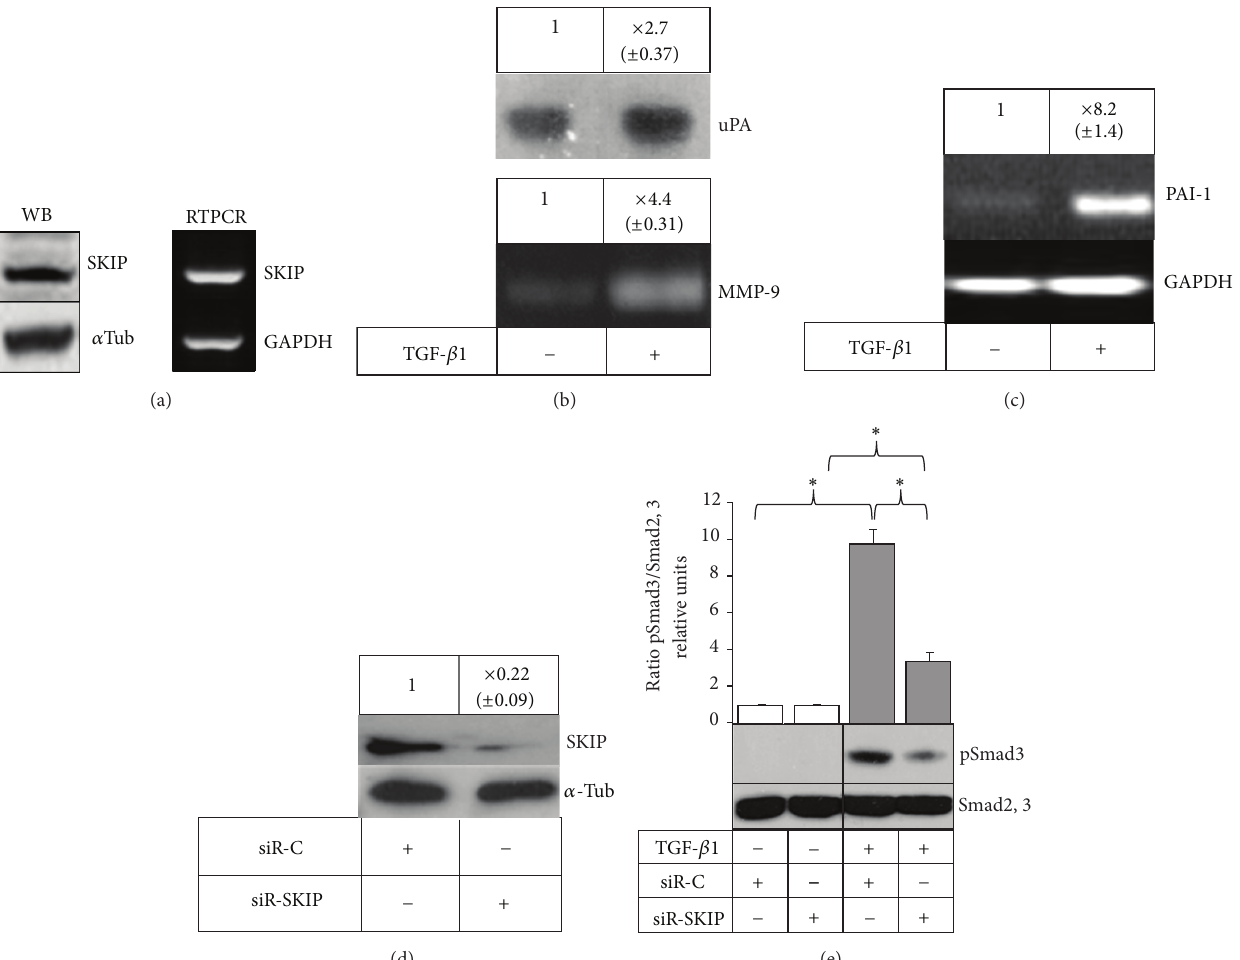
Figure 1: SKIP and TGF- 𝛽 1-induced uPA, PAI-1, and MMP-9 expressions in PC-3 cells. The effect of SKIP knockdown on TGF- 𝛽 1-induced Smad3 phosphorylation in PC-3 cells. (a) Expression of SKIP in PC-3 cells treated with TGF- 𝛽 1 determined by Western blot and RT-PCR; 𝛼 -tubulin and GADPH were used as a control of protein and cDNA loading, respectively. (b) Zymography analysis of uPA and MMP-9 in PC-3 cells treated with TGF- 𝛽 1 for 24h. (c) RT-PCR analysis for PAI-1 expression in PC-3 cells treated with TGF- 𝛽 1 for 24 h. GADPH was used as housekeeper gene to verify the equal amount of cDNA in each sample. (d) SKIP siRNA knockdown in PC-3 cells determined by Western Blot. Cells were transfected with control siRNA (siR-C) or siRNA against SKIP (siR-SKIP). (e) Smad3 phosphorylation after 60min of TGF- 𝛽 1 treatment, determined by Western Blot in siR-C or siR-SKIP transfected